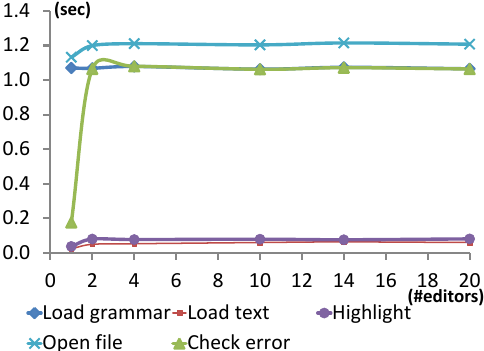
Figure 9. Effect of varying the number of concurrent editors, written in the Petri nets grammar.